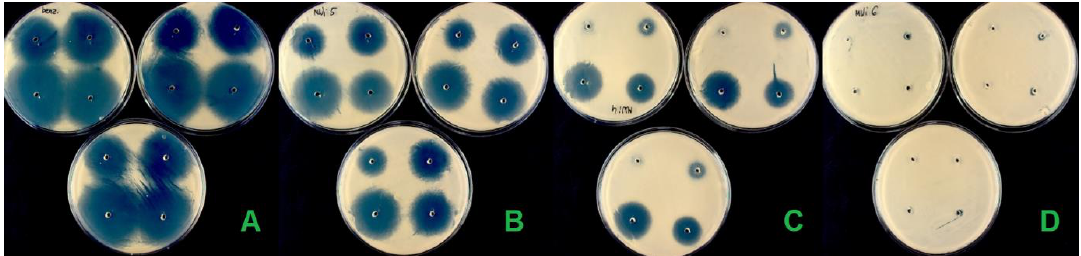
Figure 5. Three repetitions of the agar diffusion method tests for compounds: 6 ( A ), 5 ( B ), 11 ( C ) and 14 ( D ). 14 ( D